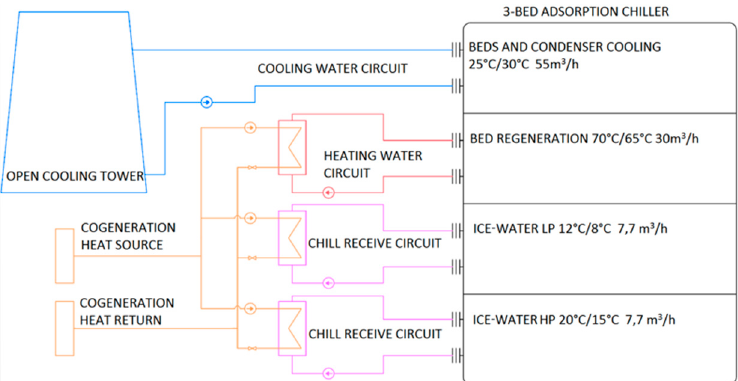
Figure 1. Simplified test stand scheme.